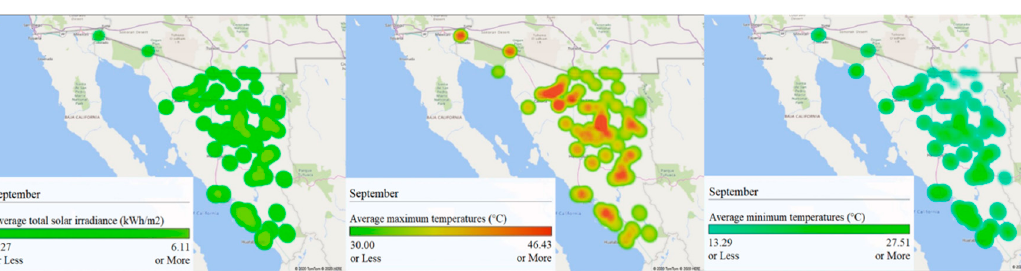
Figure 16. GIS analysis of Sonora for October: ( left ) average total solar irradiance (kWh/m 2 ), ( center ) maximum average temperatures (°C), and ( right ) minimum average temperatures (°C).